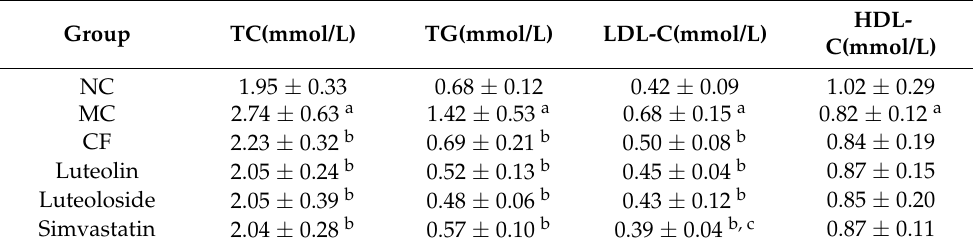
Table 5. The serum levels of TG, TC, HDL-C, and LDL-C in serum in each